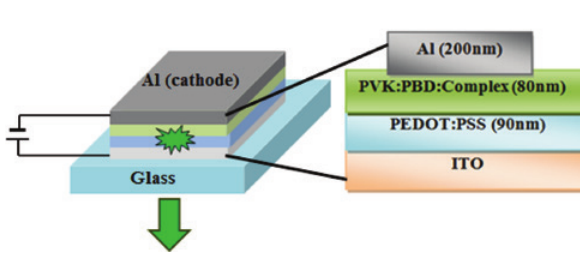
Figure 6: Layer arrangement and layer thickness of the OLED